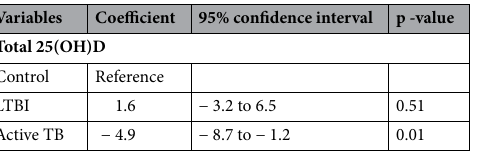
Table 5. Association of total 25(OH) D and TB status. p value = 0.05 is